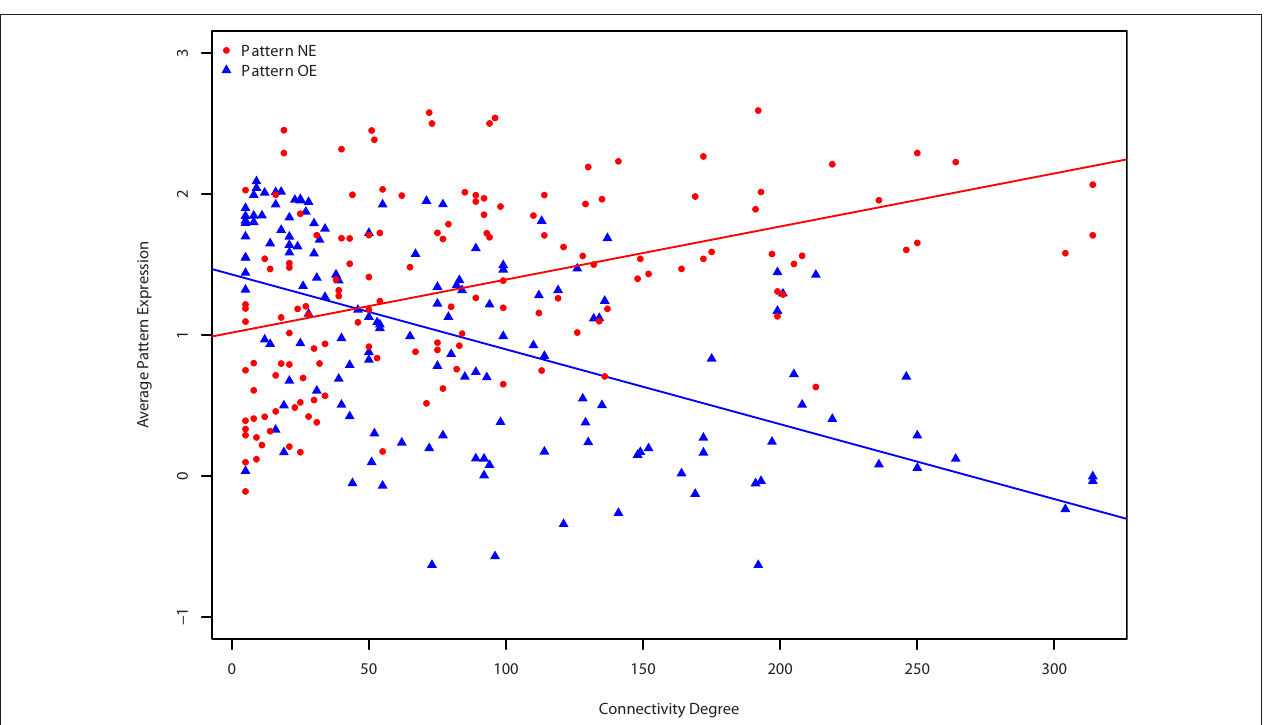
Figure 5 | relationships between degree and expression patterns. Connectivity degree is plotted against average pattern NE (red circles) and OE (blue triangles) expression levels for each brain region. Degree for the 142 regions is the sum of both incoming and outgoing